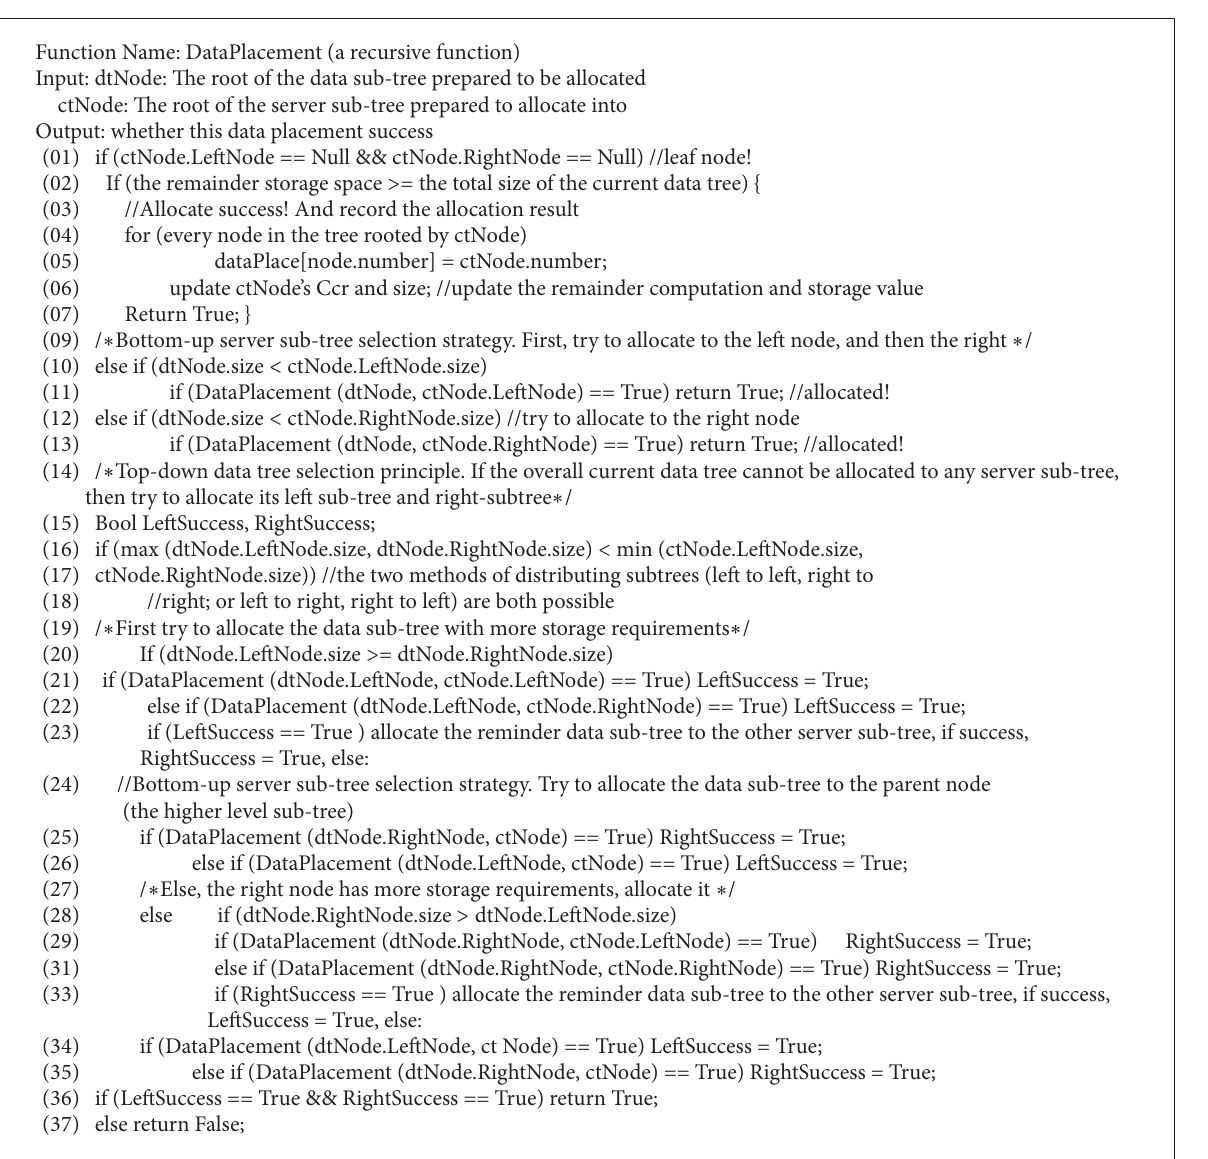
algorithm, the average performance indicators are